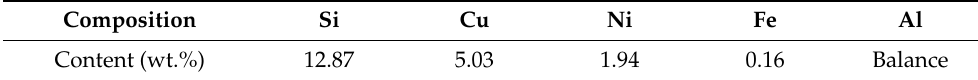
Table 1. Chemical composition of the Al-Si-Cu alloys (wt.%).